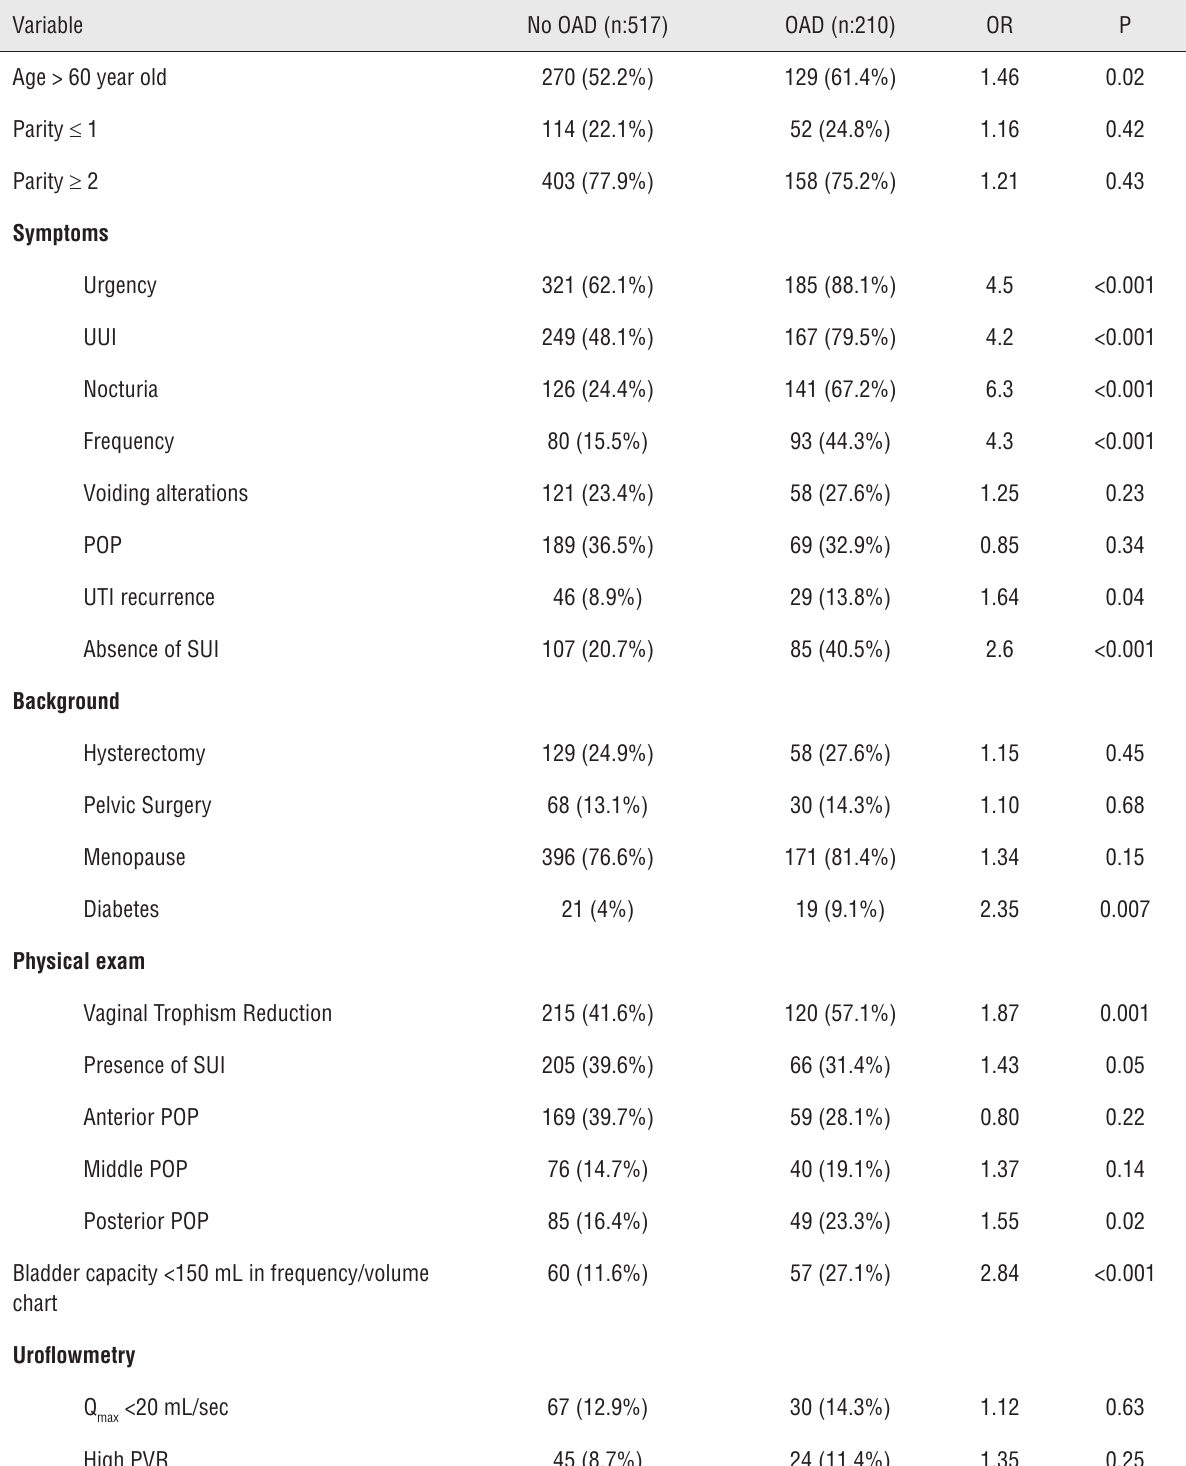
Table 1 - Comparison of clinical and urodynamic profile of patients with and without OAD.